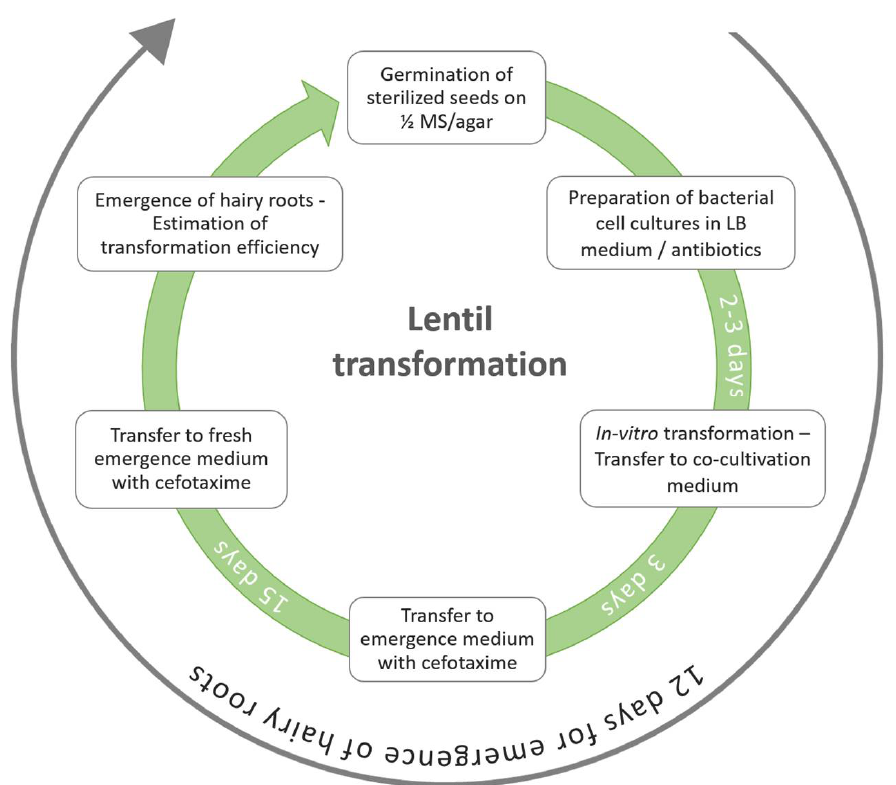
Figure 2. Stepwise protocol for A. rhizogenes -mediated hairy root induction in lentil.